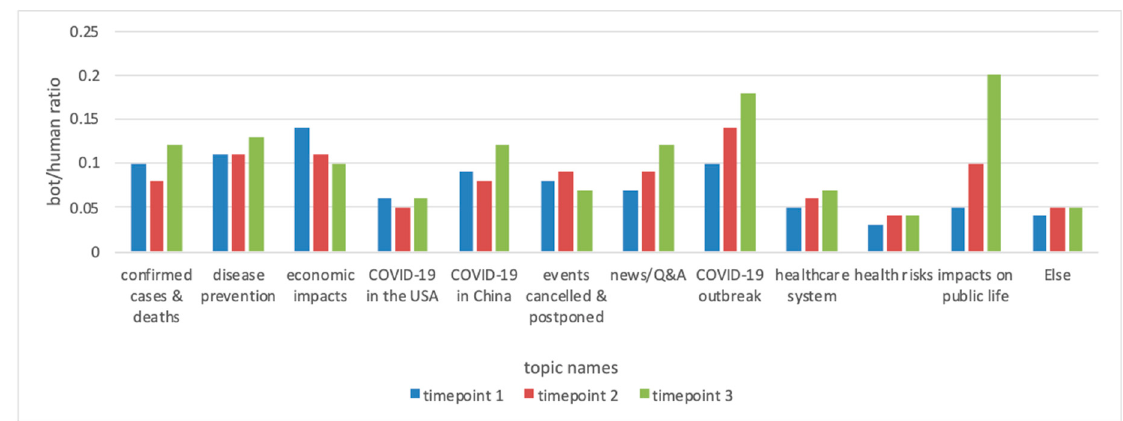
Figure 2. Bot/human ratio for each topic at three time points. Figure 2. Bot / human ratio for each topic at three time